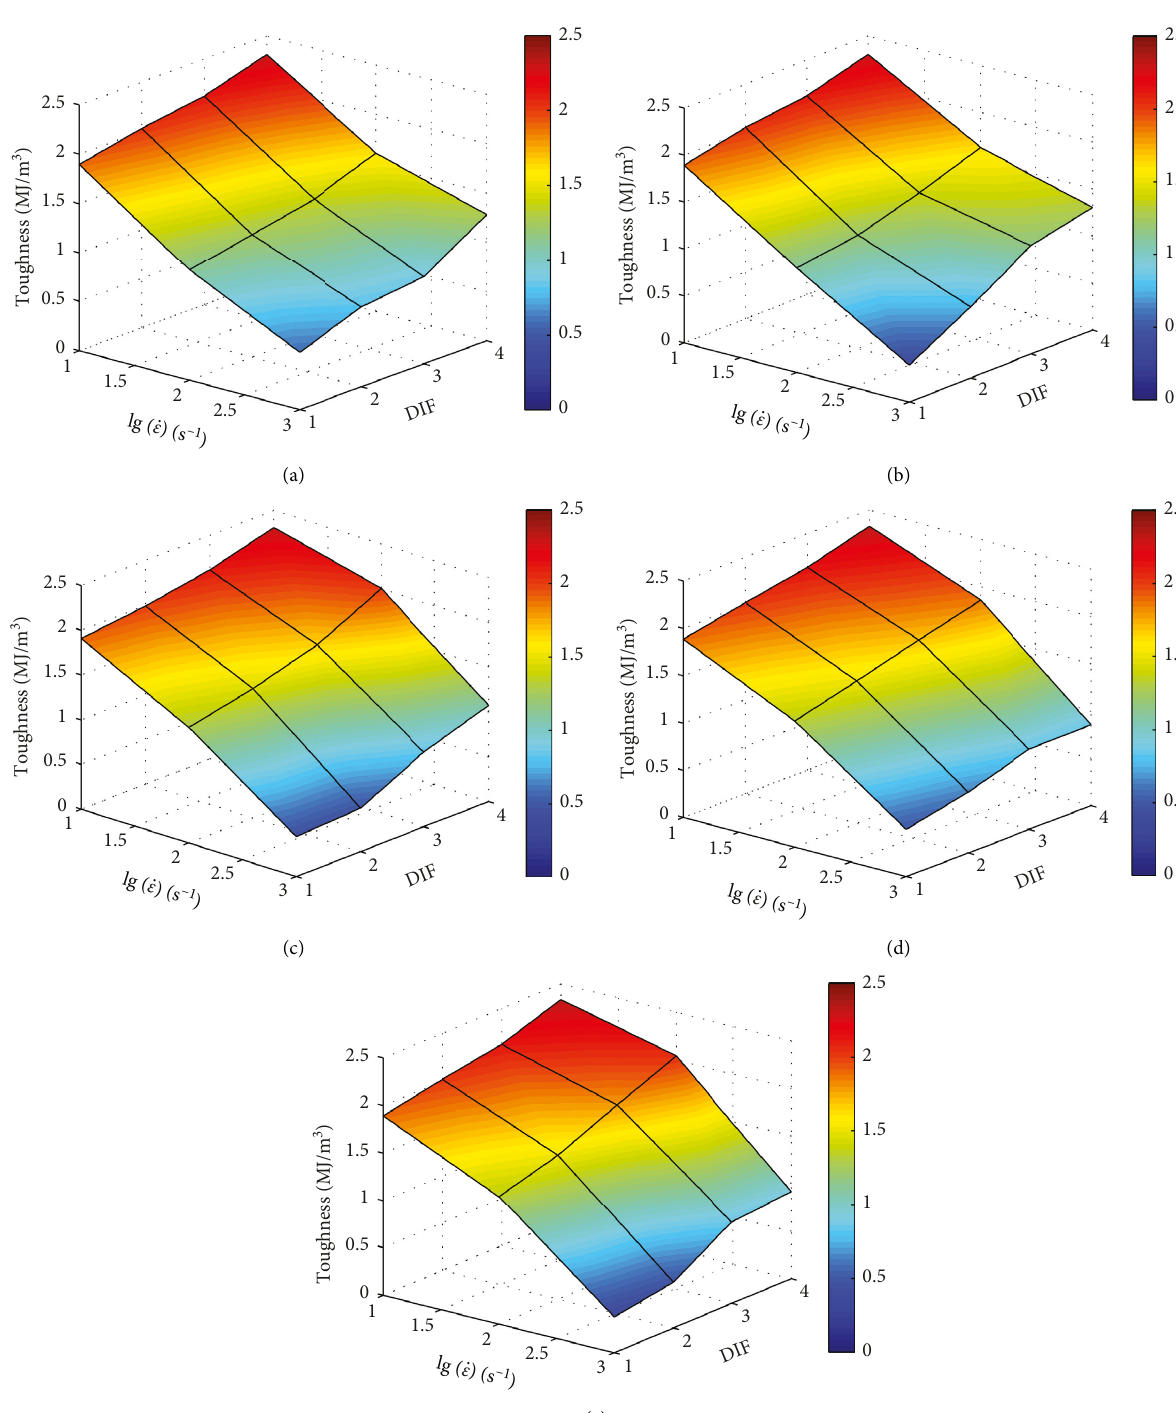
Figure 13: The relationship between lg _ ε , DIF, and toughness. (a) FT0. (b) FT25. (c) FT50. (d) FT75. (e)